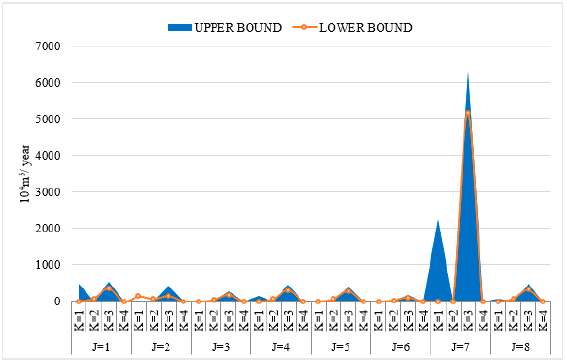
Figure 16. Water reuse in water use departments under the high level of available water resources.